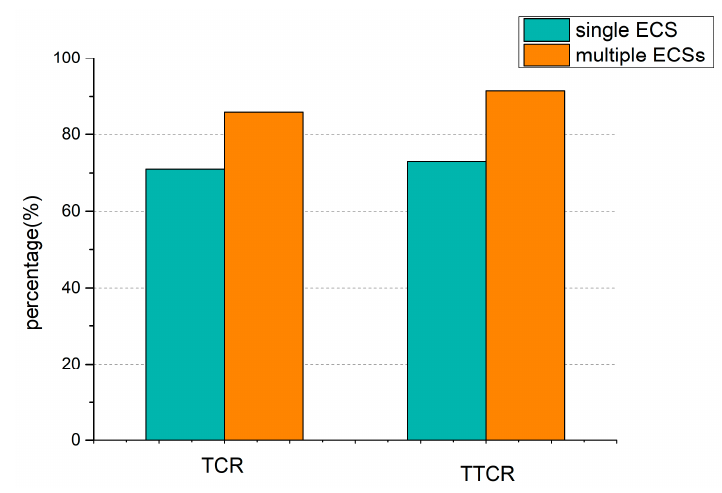
Figure 6. TCR of single edge computing servers (ECS) and multiple ECSs.